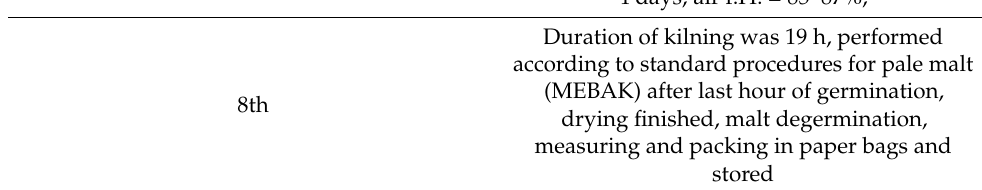
according to standard procedures for pale malt (MEBAK) after last hour of germination, drying finished, malt degermination,